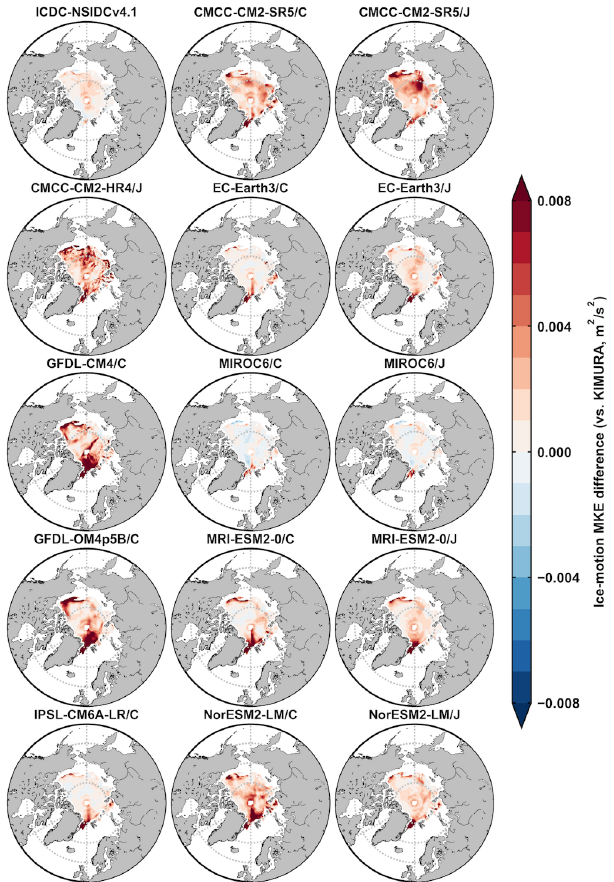
Figure A10. The 2003–2007 February mean Arctic ice-motion MKE differences between ICDC-NSIDCv4.1/model outputs and the KIMURA data (m 2 s − 2 ). The second and third columns are from the five OMIP1 and OMIP2 model outputs of CMCC-CM2- SR5, EC-Earth3, MIROC6, MRI-ESM2-0, and NorESM2-LM, re-